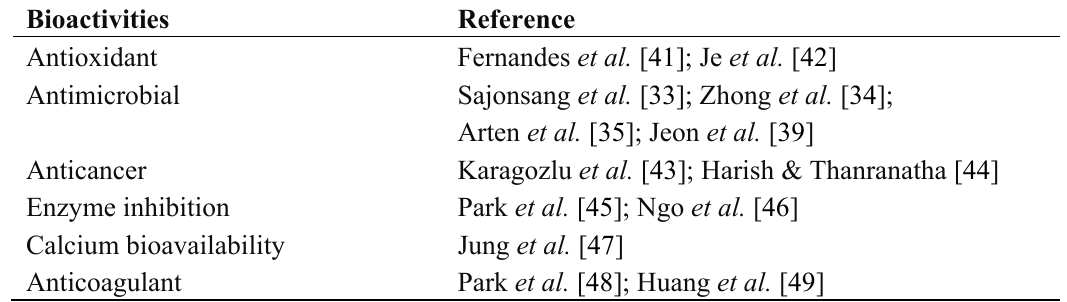
Table 1. Biological activities of chitooligosaccharides produced by membrane bioreactors.